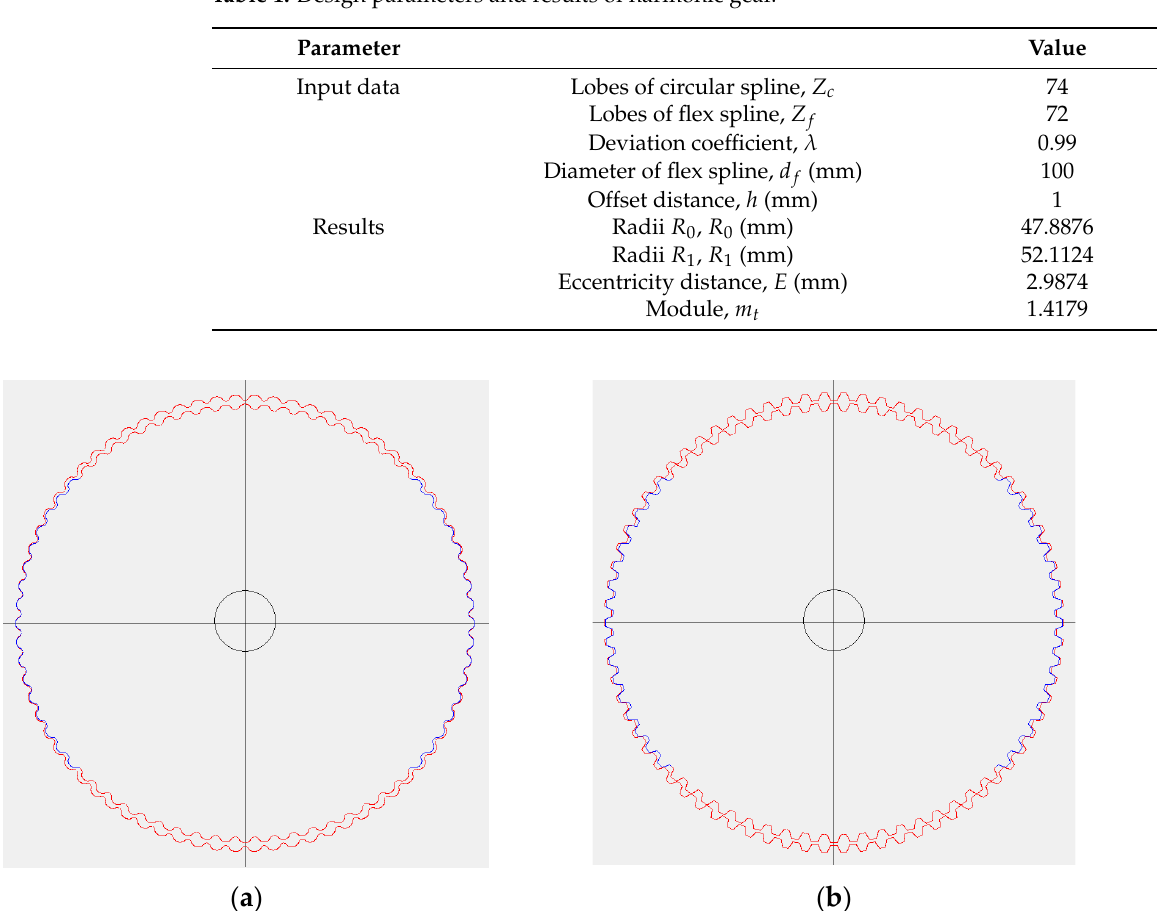
Figure 8. Program to check the gear engagement and interference: ( a ) Cycloid ( b ) Involute.